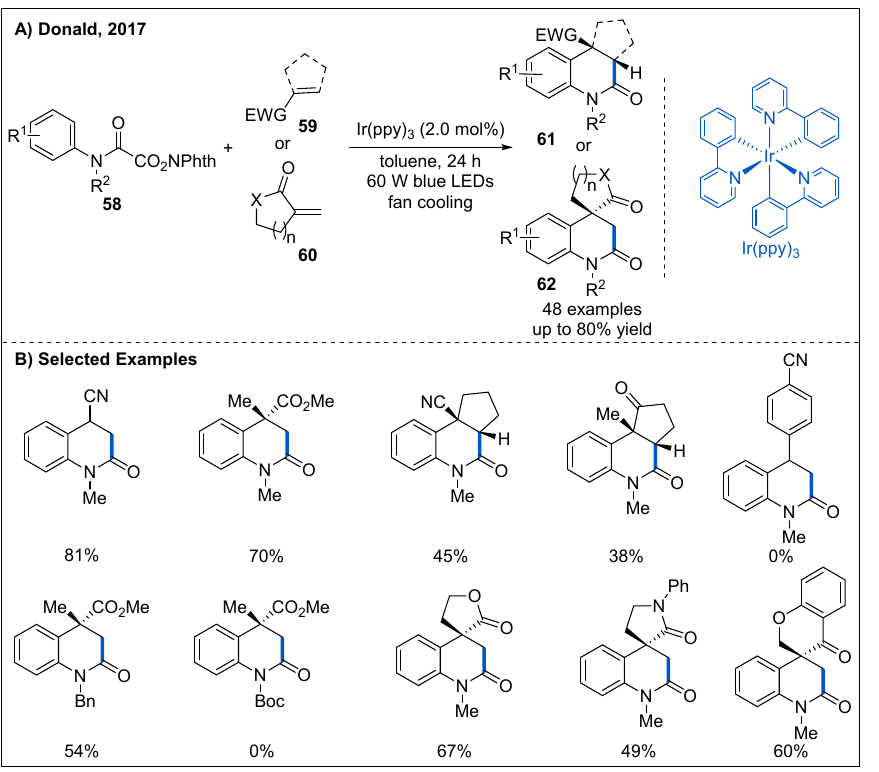
Figure 20. Amide synthesis by intermolecular decarboxylative